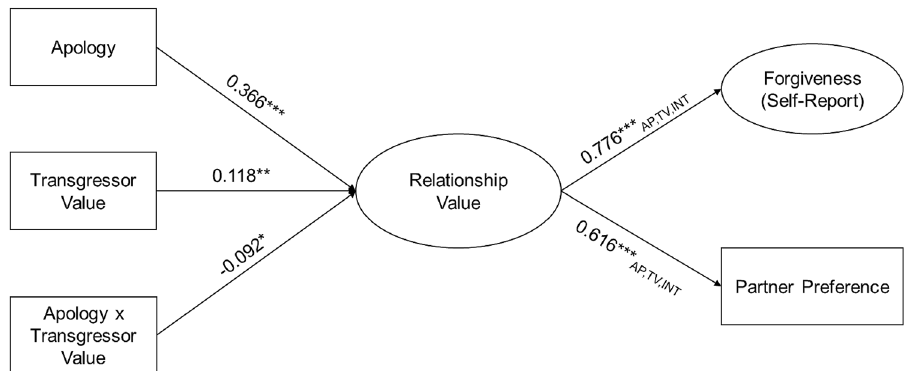
Figure 3. Path model depicting unstandardized direct and indirect effects of the apology (− 1 = no apology, 1 = apology) and transgressor value (− 1 = Low, 1 = High) manipulations, as well as their interaction, on measured relationship value, forgiveness, and preference to interact with the transgressor. A complete list of direct and indirect effects is in Table 2. Significant indirect effects are marked by subscripts from the mediator to the